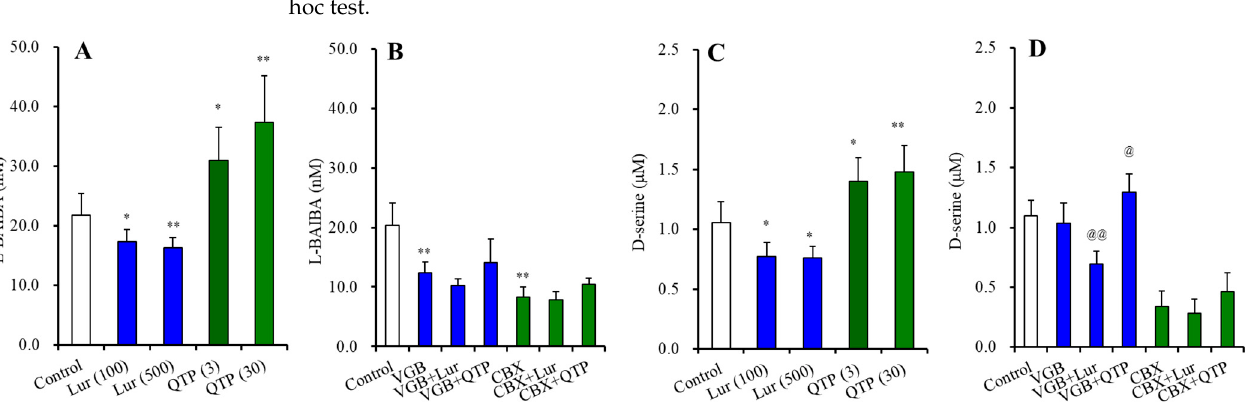
Figure 10. Concentration-dependent effects of chronic exposure lurasidone (Lur: 100 and 500 nM for 14 d) and quetiapine (QTP: 3 and 30 µ M for 14 d) on astroglial ripple-evoked releases of L-BAIBA ( A ) and D-serine ( C ). Interaction among chronic exposures of antipsychotics (100 nM lurasidone and 3 µ M quetiapine) and chronic exposure of 200 µ M vigabatrin (VGB: ABAT inhibitor) or 100 µ M carbenoxolone (CBX: astroglial hemichannel inhibitor) on ripple-evoked releases of L-BAIBA ( B ) and D-serine ( D ). In panels ( A , B ): Ordinate: mean ± SD ( n = 6) of levels of L-BAIBA (nM). In panels ( C , D ): Ordinate: mean ± SD ( n = 6) of levels of D-serine (µM). * p < 0.05, ** p < 0.01: relative to control